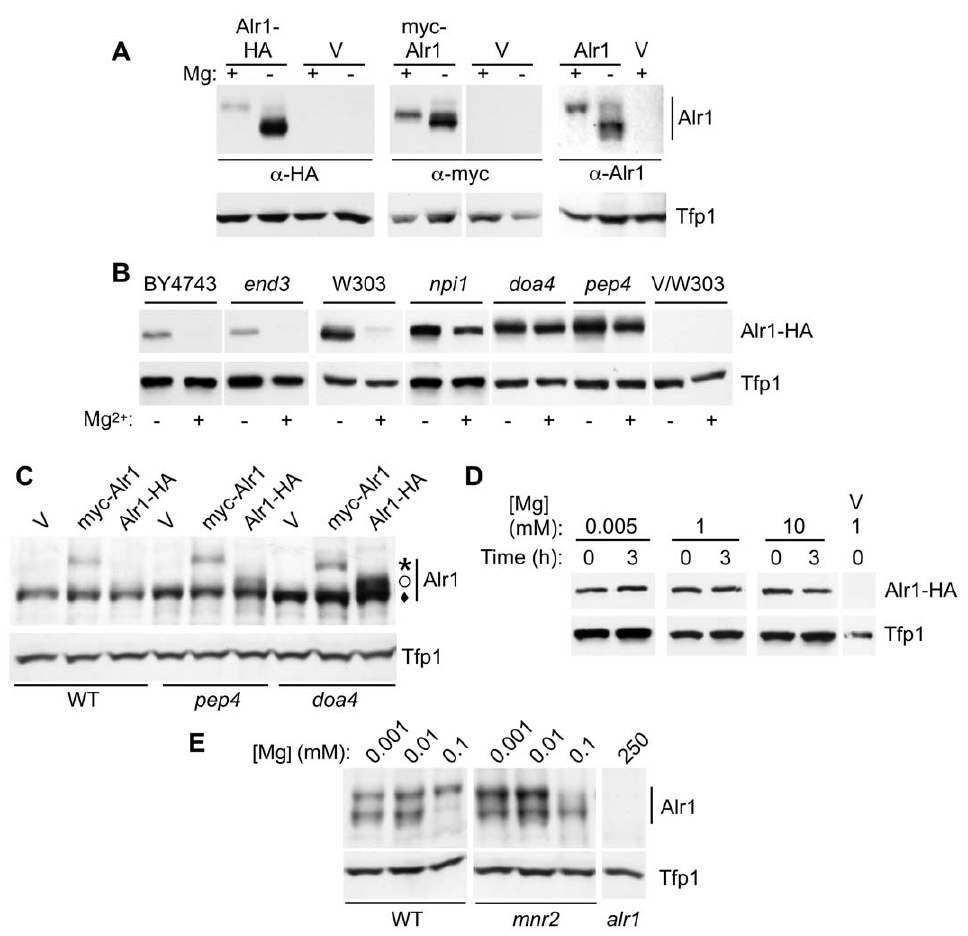
Figure 4. Effect of epitope tagging on Alr1 accumulation. ( A ) DY1457 transformed with YCpALR1-HA (left panel), or YCpmyc-ALR1 (center), and an alr1 strain (NP10) transformed with YCpALR1 (right), or an empty vector (pFL38, V) were grown in LMM + 1 m M ( 2 ) or 1 mM Mg ( + ). Alr1 and Tfp1 (as loading control) were detected by SDS-PAGE and immunoblotting with anti-HA, anti-myc, or anti-Alr1 antibodies. ( B ) Strains of the indicated genotypes transformed with YCpALR1-HA were grown in LMM supplemented with 1 m M ( 2 ) or 1 mM ( + ) Mg, and proteins detected by immunoblotting with anti-HA and anti-Tfp1. Strains used were WT (BY4743 or W303-1B), 32992 ( end3 ), SD20 ( doa4 ) 27038a ( npi1 ), MOB100 ( pep4 ), and W303-1B transformed with pFL38 (V/W303). Results for the NPI1 strain isogenic to 27038a (23344C) were similar to W303-1B (not shown). ( C ) WT (W303-1B), pep4 (MOB100) and doa4 (SD20) strains transformed with YCpmyc-ALR1 (myc-Alr1), YCpALR1-HA (Alr1-HA) or pFL38 control (V) were grown in Mg-replete medium (SC). Proteins were detected by immunoblotting with anti-Alr1 and anti-Tfp1. The three versions of Alr1 are indicated (star=myc-Alr1, open circle=Alr1-HA, diamond=untagged Alr1). ( D ) FY1679/YIpALR1-HA cells were grown in LMM containing 5 m M Mg for 12 hours. Cells were then transferred to LMM with 5 m M, 1 mM, or 10 mM Mg, and 100 m g/ml cycloheximide. Aliquots of cells were removed after 0 or 180 minutes, protein extracted, and proteins detected by immunoblotting with anti-HA and anti-Tfp1 antibodies. FY1679 transformed with pFL38 was included to verify antibody specificity (V). ( E ) WT (DY1457), mnr2 (NP4), and alr1 (NP10) strains were grown in LMM medium supplemented with the indicated Mg concentration. Proteins were detected by immunoblotting with anti-Alr1 and anti-Tfp1 antibodies.